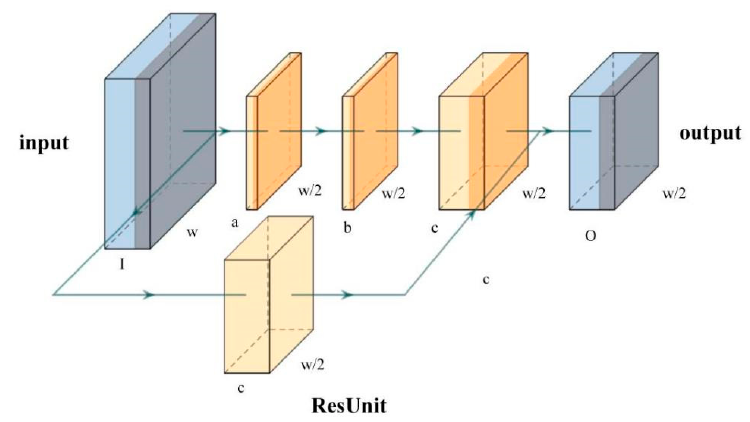
Figure 4. Bottleneck residual unit.